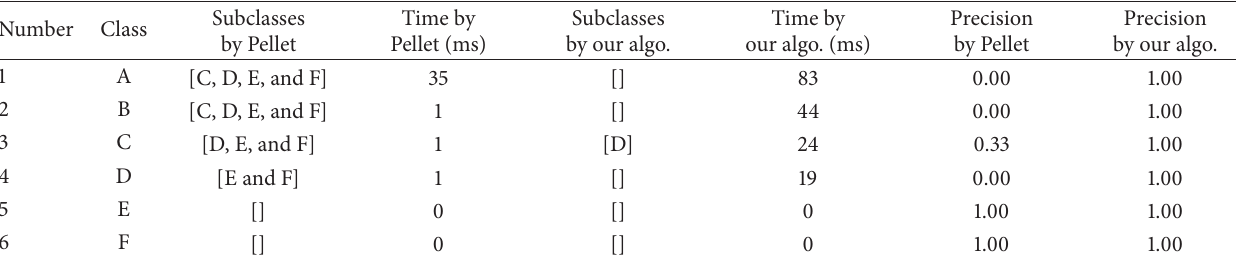
Table 5: Calculating list of subclasses: case 3.